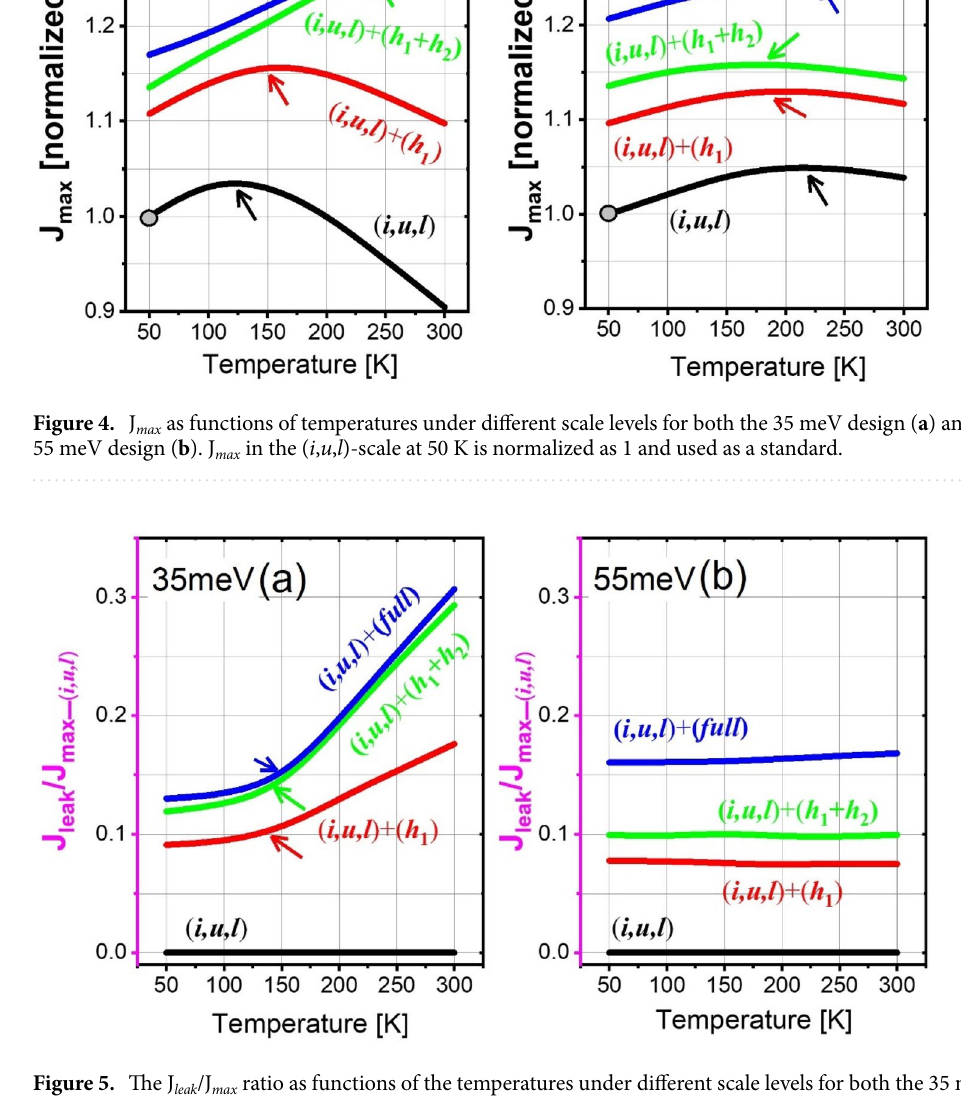
Figure 5. The J leak /J max ratio as functions of the temperatures under different scale levels for both the 35 meV design ( a ) and 55 meV design ( b ). J max in the ( i , u , l )-scale is normalized as 1 and used as a standard. There are